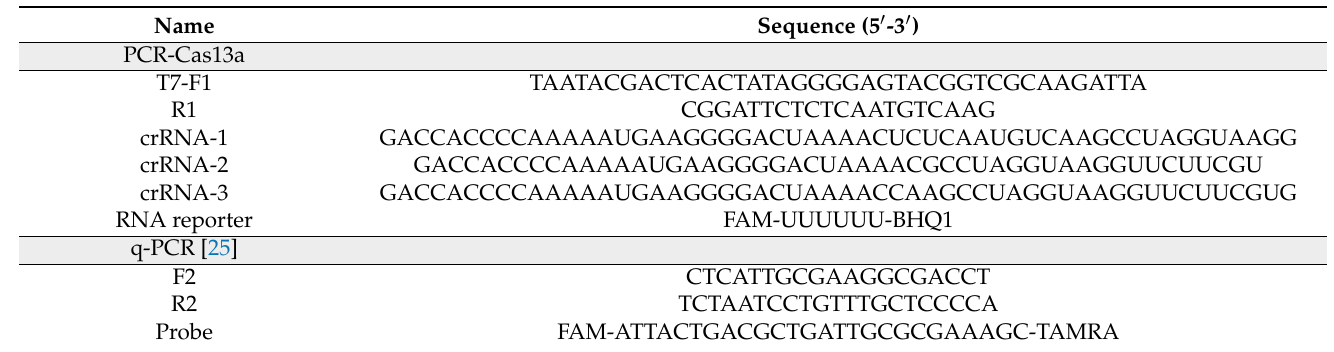
Table 1. The oligonucleotide sequences used in this